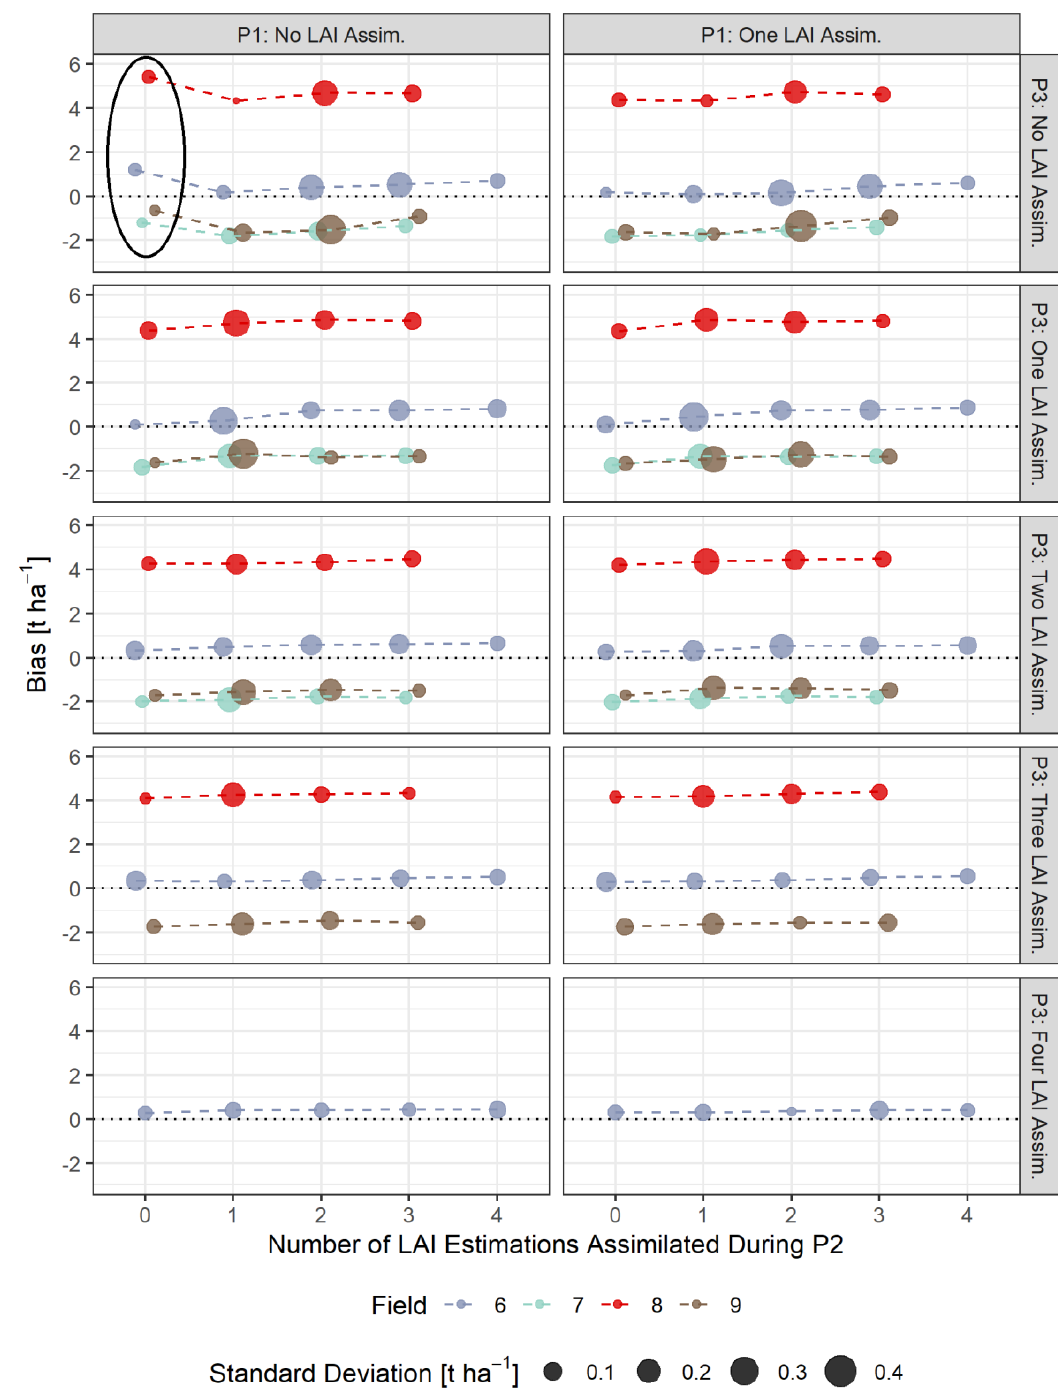
Figure 7. Mean Bias of total aboveground biomass predictions for fields 6–9. See caption of Figure 6 for further explanations.